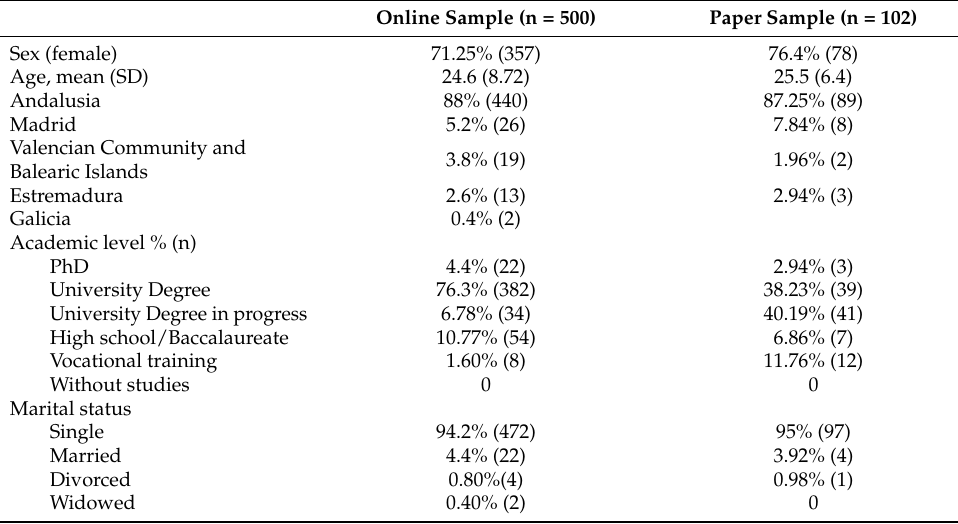
Table 1. Socio-demographic data of participants (N =